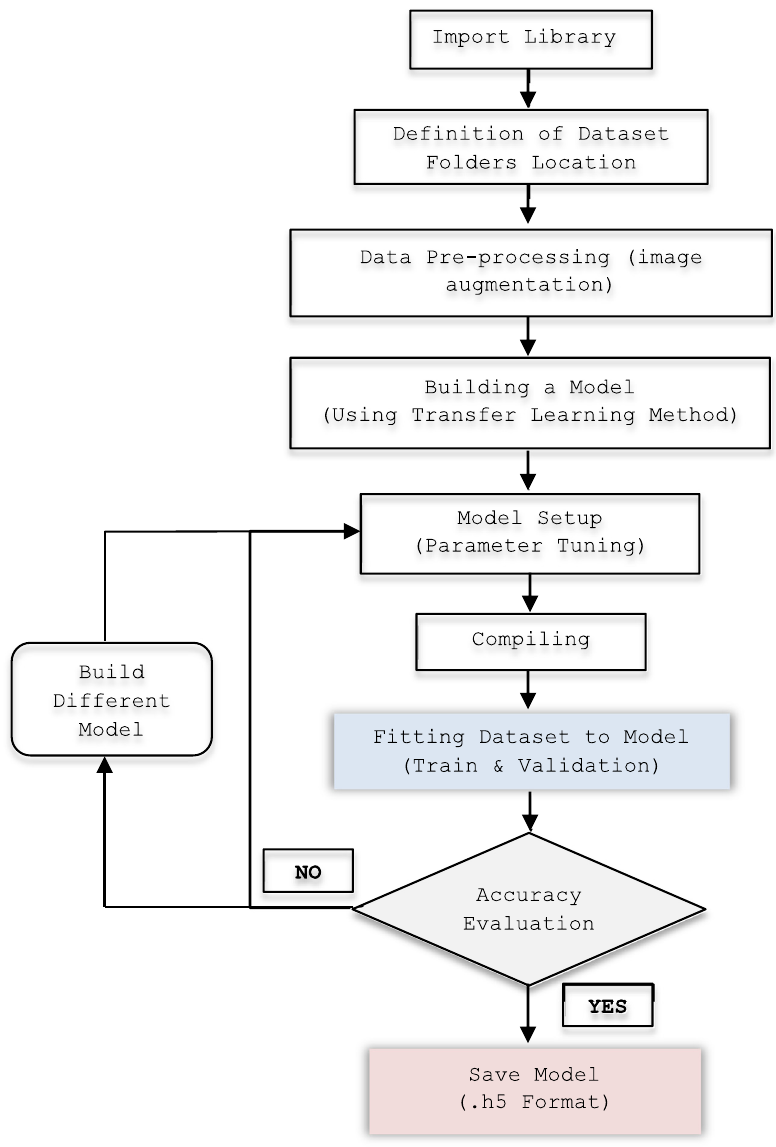
Figure 7: Flow chart of programming and training